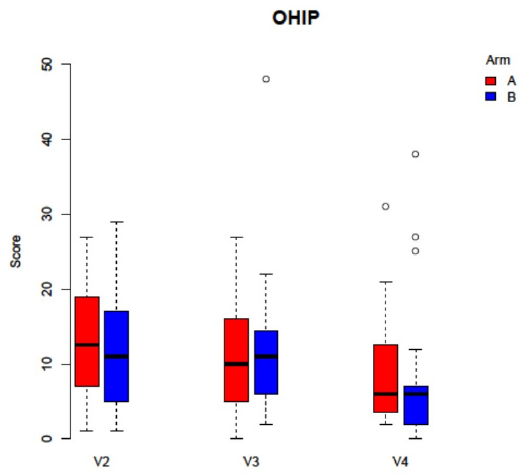
Figure 5. Analysis of the VAS score did not display any statistically significant differences between the study arms (Arm A: − PRF, Arm B: +PRF, V2 p = 0.169, V3 p = 0.406, V4 p = 0.155).